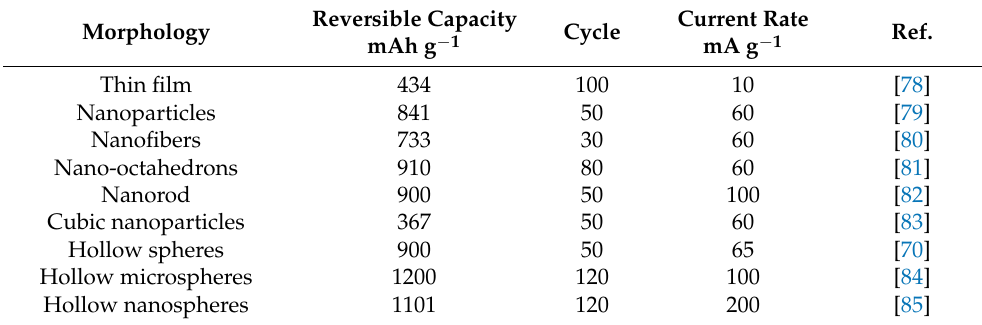
Table 1. Morphology dependent electrochemical performance of ZnFe 2 O 4 as